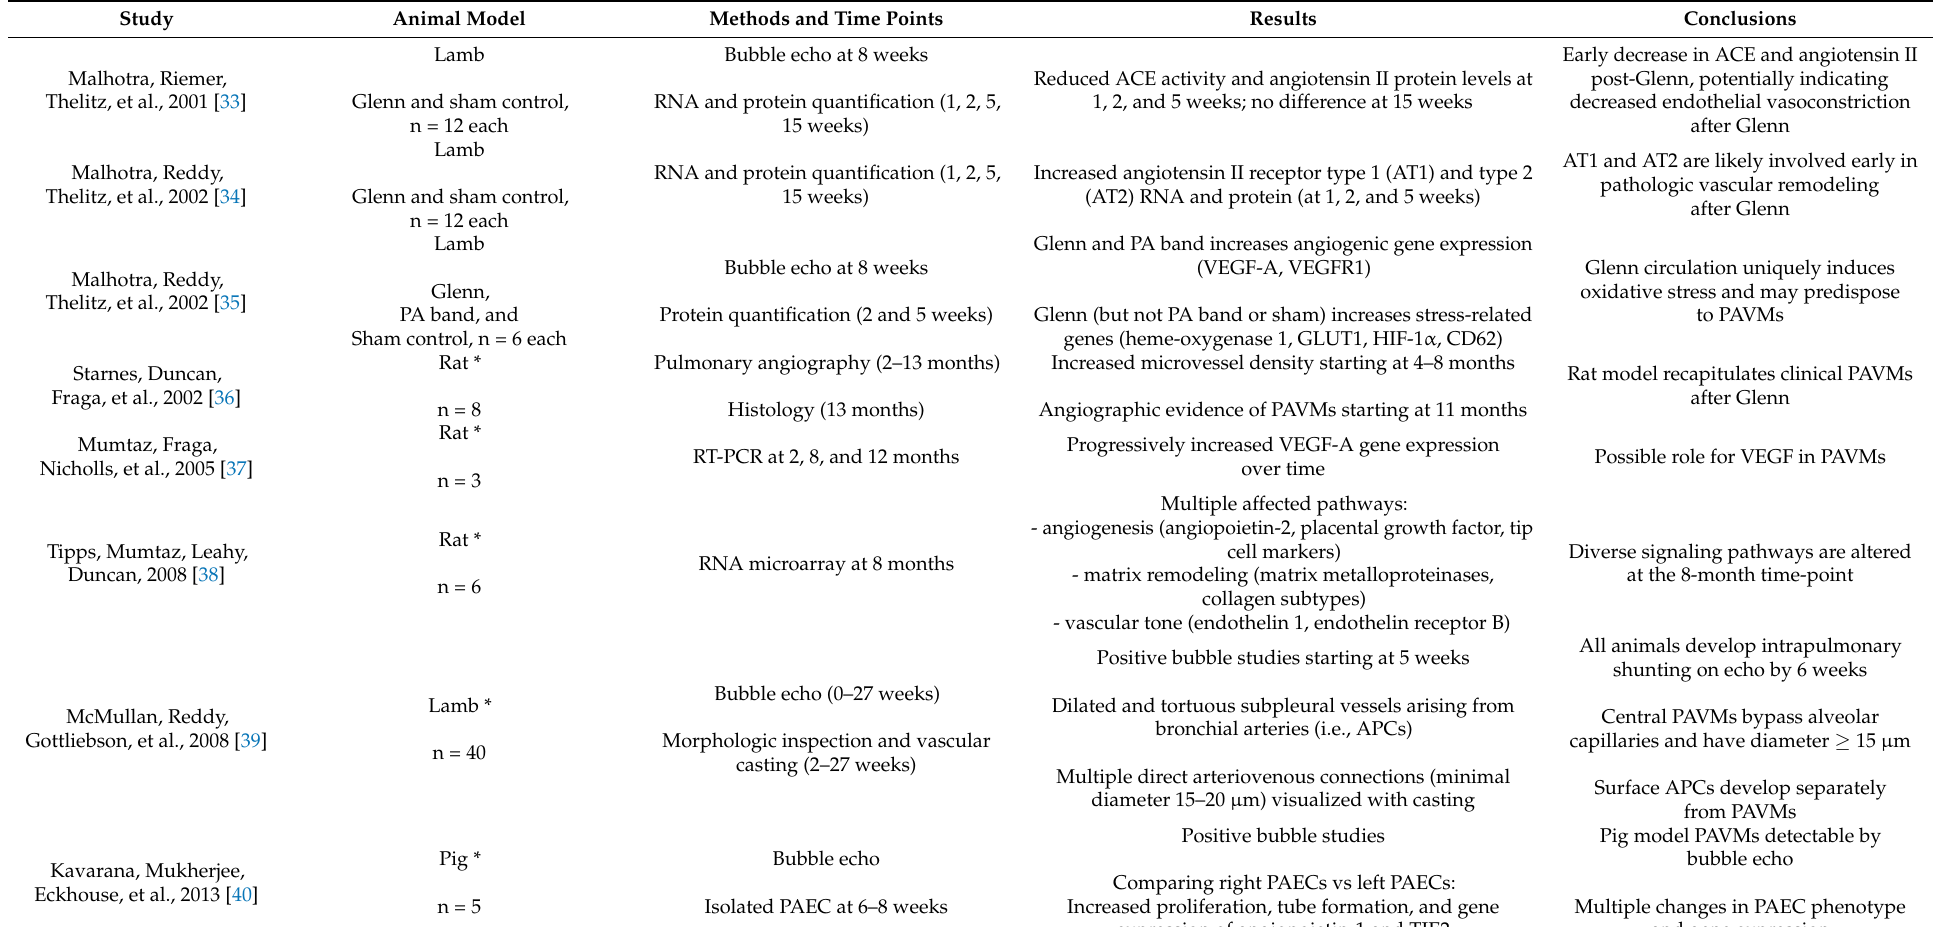
Table 1. Studies using animal models of Glenn